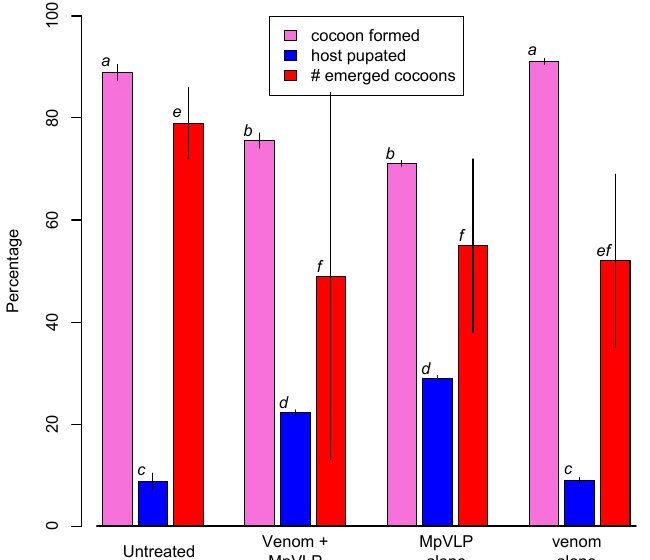
Figure 13. Effects of injection of M. pulchricornis products into northern armyworm, Mythimna separata (Noctuidae) caterpillars parasitised (on the same day) by Cotesia kariyai . Different letters above columns indicate significantly different values at 5% level using Tukey–Kramer test. (Data from Table 2B in [205]). Arbitrary sequencing of clones based on a conventional cDNA library construction from the VG filaments, which produce both venom and the MpVLPs, yielded 473 inde- pendent cDNA clones which formed 228 clusters [52]. BLAST2GO (BLAST to gene ontol- ogy) analysis of the clusters allowed 105 of the sequences to be annotated. Twenty of the clusters were fully sequenced (summarised in Table 6). Twelve of these were highly adult- specific and two were associated the the MpVLPs. RNA interference experiments were carried out to produce MpVLPs that were deficient in these two factors. In in vitro assays of the effects of the VLPs on haemocyte spreading, the modified VLPs were found to be less effective at inhibiting haemocyte spreading than un-modified ones. Table 6. Putative functions of selected cDNA gene clusters from venom gland (VG) filaments of Meteorus pulchricornis (Source: based on [52]). Putative Function